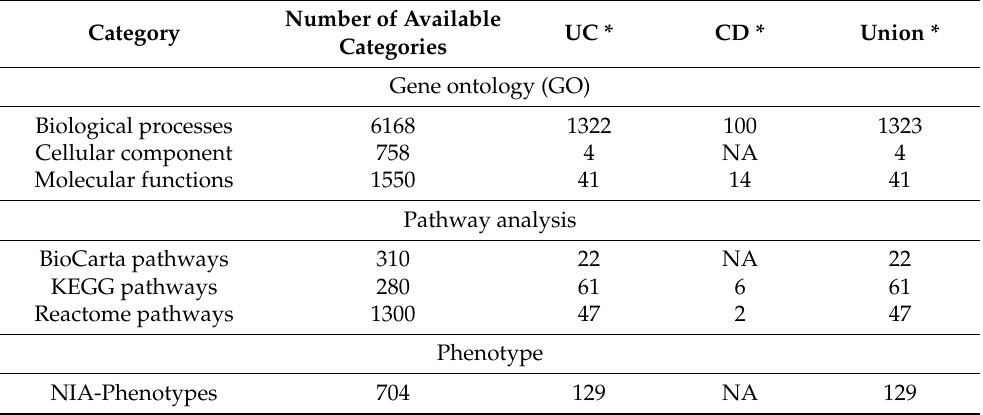
Table 5. The union of functional enrichment analysis of cytokines differentially expressed in ulcerative colitis and Crohn’s disease. UC, ulcerative colitis; CD, Crohn’s disease; NA, not applicable; *, number of significant categories. Number of Category